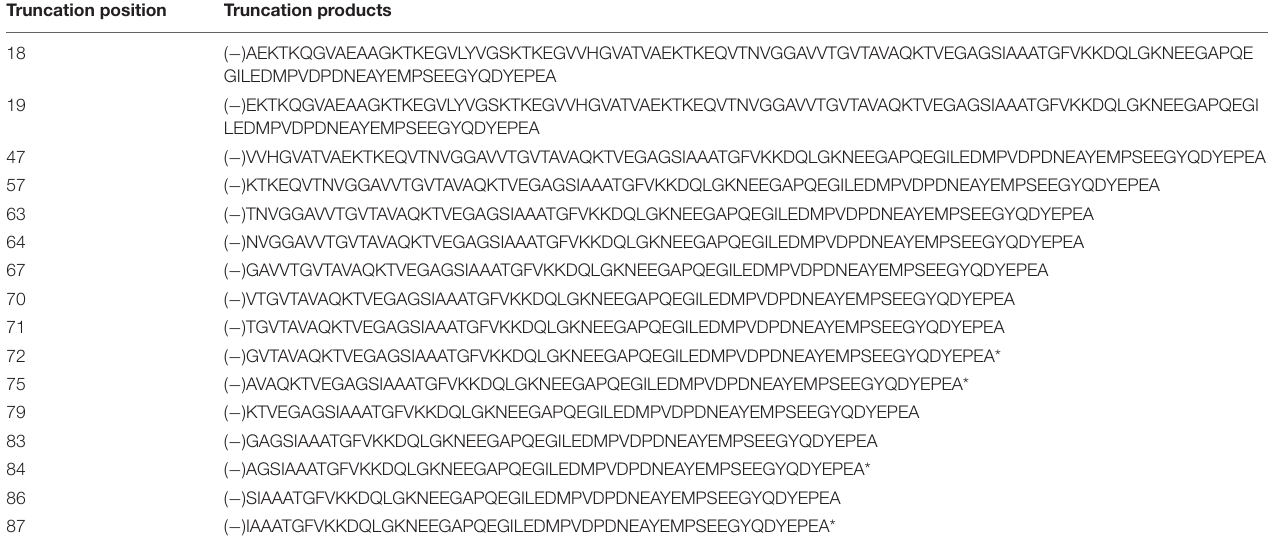
TABLE 1 | Alpha synuclein truncation products (-AA): Nter